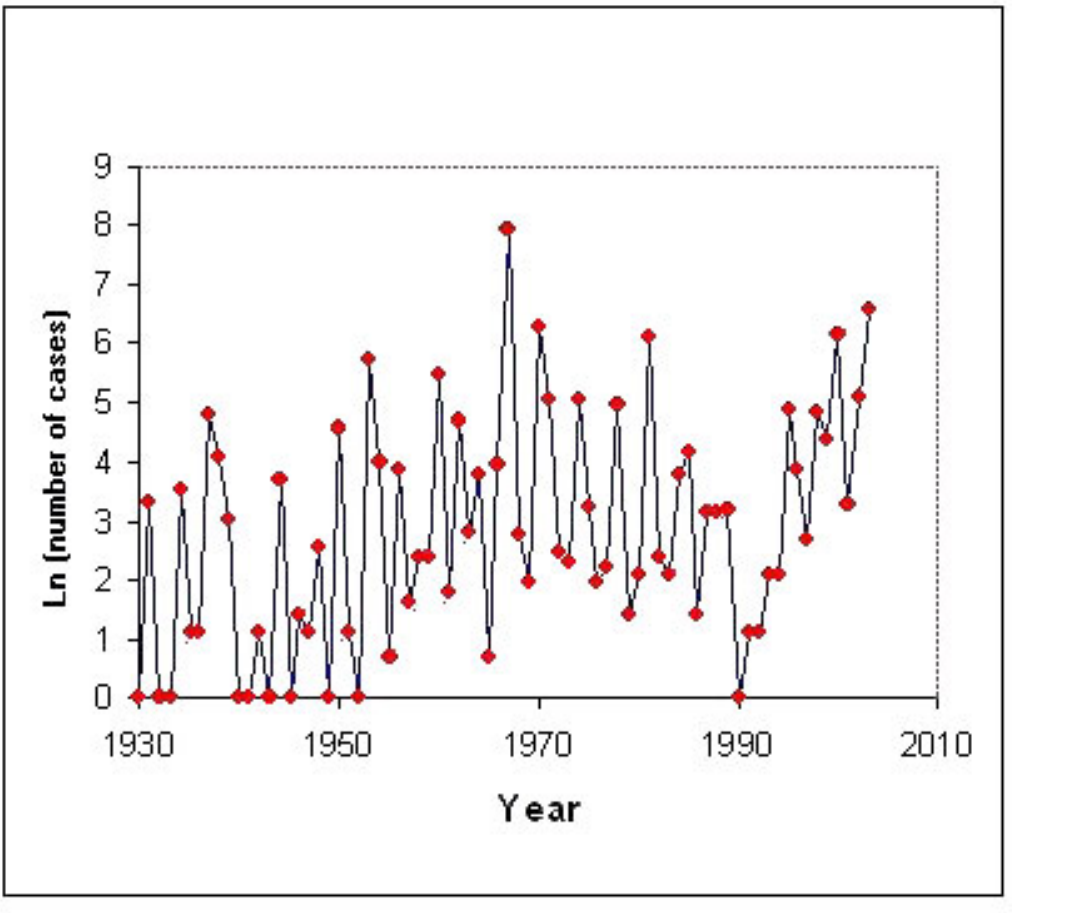
Fig. 1. Variation in the number of tularemia cases in Sweden. Data are Ln( x + 1)